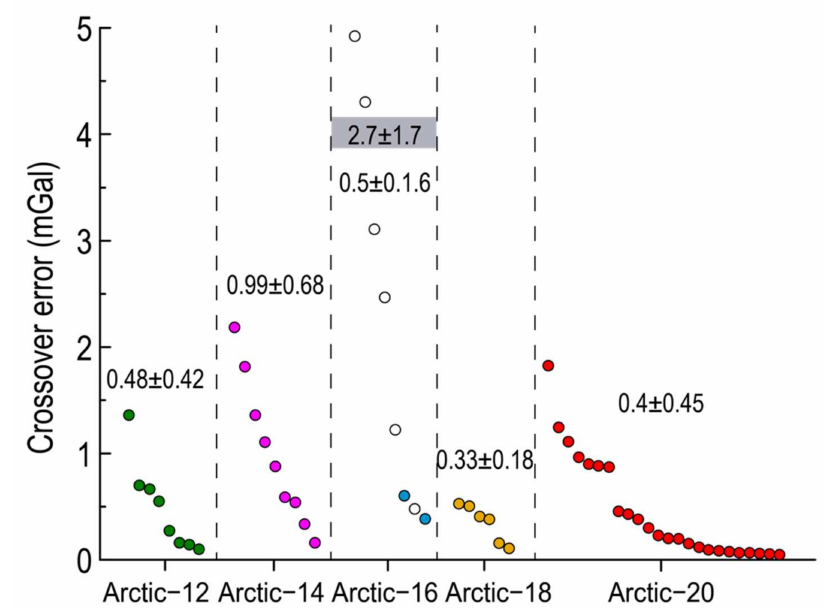
Figure 2. Crossover errors of shipborne gravity. The abscissa represents different survey voyages. The solid circles of different colors indicate crossover errors of different survey voyages in an ice-free region. The hollow circles indicate crossover errors in an ice-covered region. Numbers without shadow and gray boxed numbers indicate the mean ± standard deviation of crossover errors of ice-free and ice-covered regions,